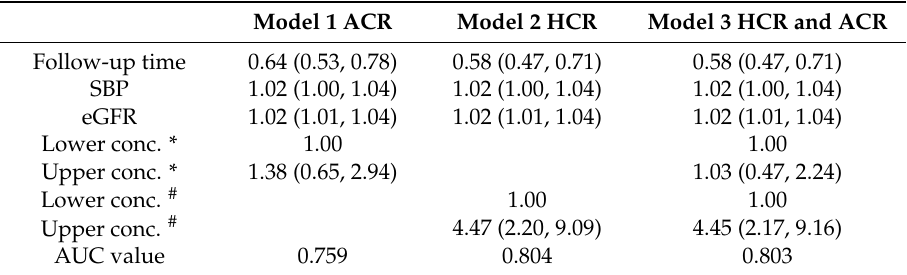
Table 3. Odds ratios with 95% confidence intervals (CI) and area under the curve (AUC) values for ERFD prediction in different logistic regression